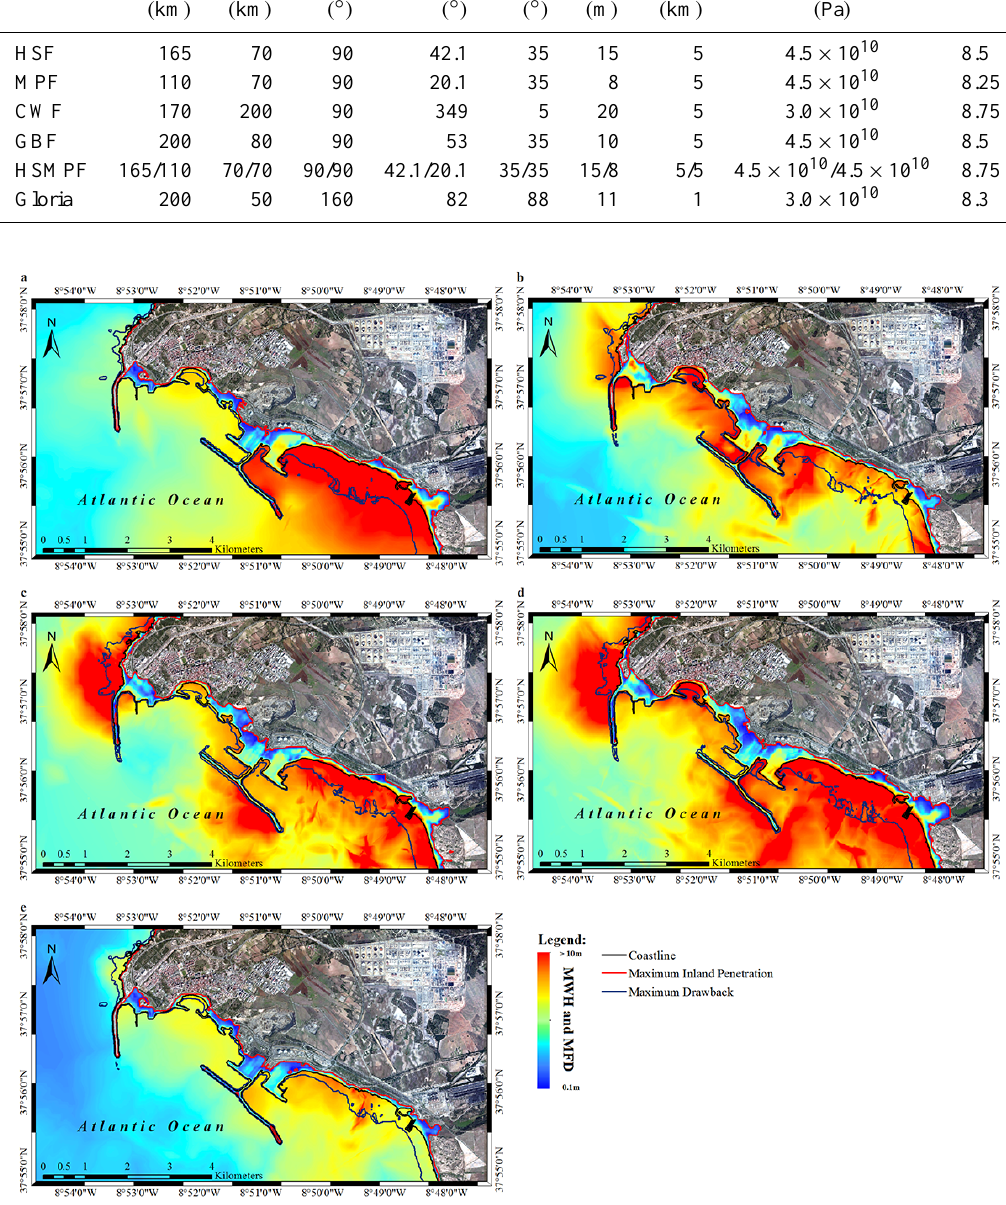
Figure 3. Results of MWH, MFD, MDB, MIA, and MIP of the SWIM scenarios considering MSL: (a) CWF; (b) GBF; (c) HSF; (d) HSMPF; (e) MPF. MWH and MFD are represented by the colour bar in the lower right corner offshore and on land respectively. Offshore and land are separated by the coastline (black line). MDB is indicated by the dark blue line. The MIA is given between the coastline and the MIP (red